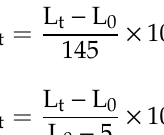
Figure 5. Expansion cracks in concrete microbar of YMS1 cured in TMAH solution for 56 days: ( a ) crack in dolomite region; ( b ) crack in calcite region. Figure 6. Expansion cracks in concrete microbar of YMS1 cured in TMAH solution for 98 days: ( a ) crack in dolomite region; ( b ) dolomite around the crack.